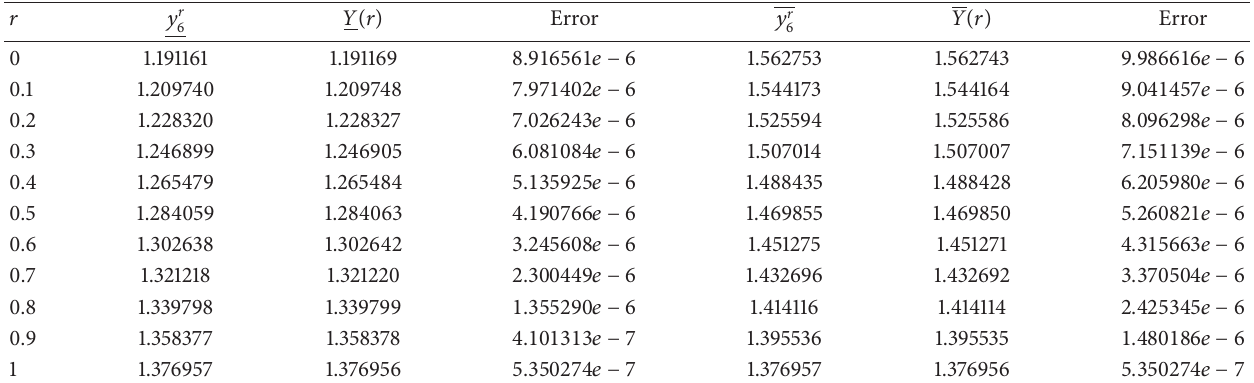
Table 3: The result of the proposed method for Example 57 with 𝛼 = 0.95 and 𝑚 = 6